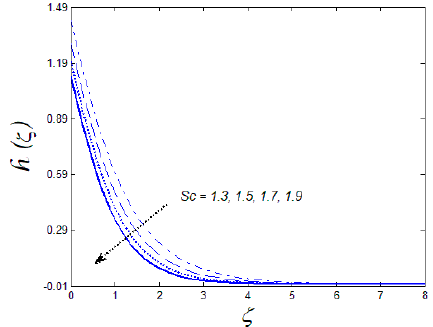
Figure 12. Upshot of S c on concentration profile h ( ζ ) .